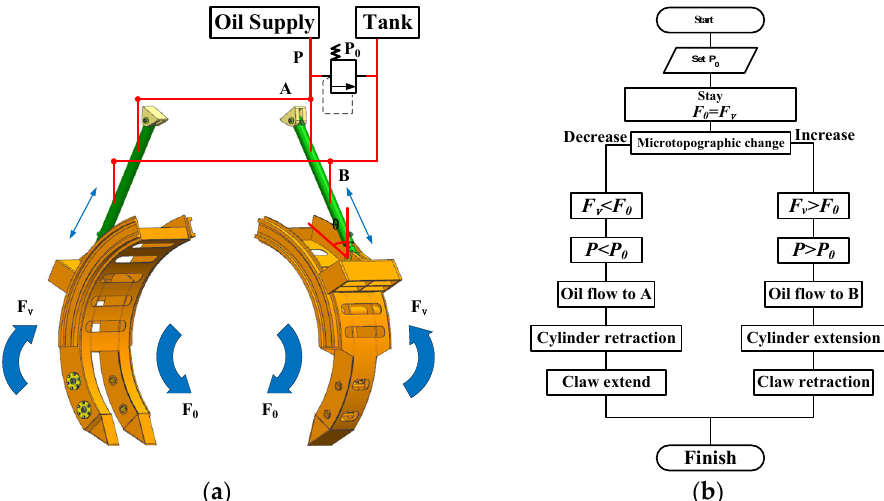
Figure 5. Synchronous motion of claws: ( a ) Hydraulic system and ( b ) Control flow chart. Table 5. Claw tip parameters.